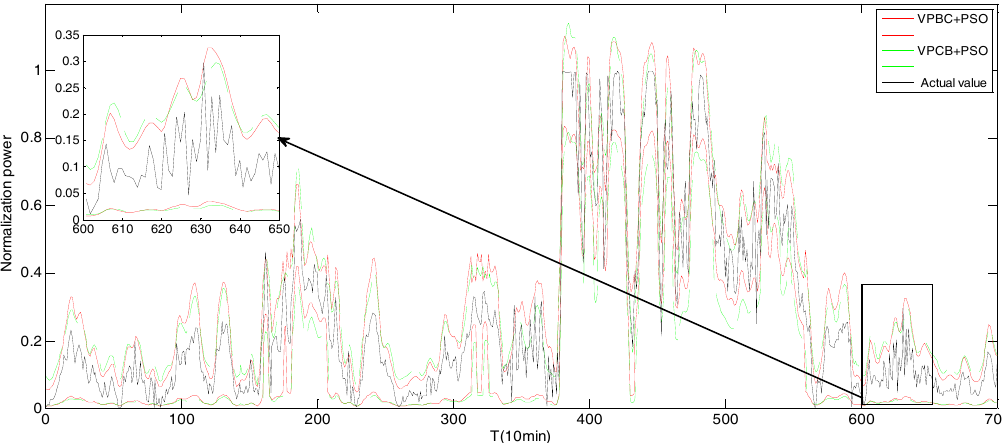
Figure 11. Forecasting results of the VPBC + PSO and VPCB + PSO methods at 85% PINC.